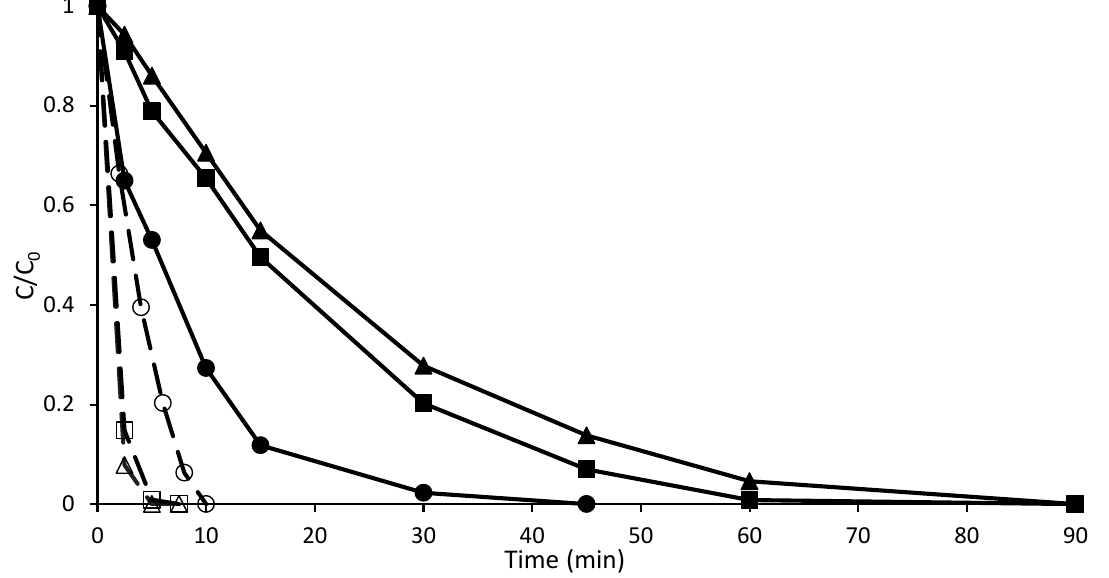
Figure 3. UVC-driven degradation of acetaminophen in the presence (21 mM) and absence of H 2 O 2 under different atmospheres: air ( ▲ ), oxygen ( ■ ), nitrogen ( ● ), air/H 2 O 2 ( ∆ ), oxygen/H 2 O 2 ( □ ), nitrogen/H 2 O 2 (O).